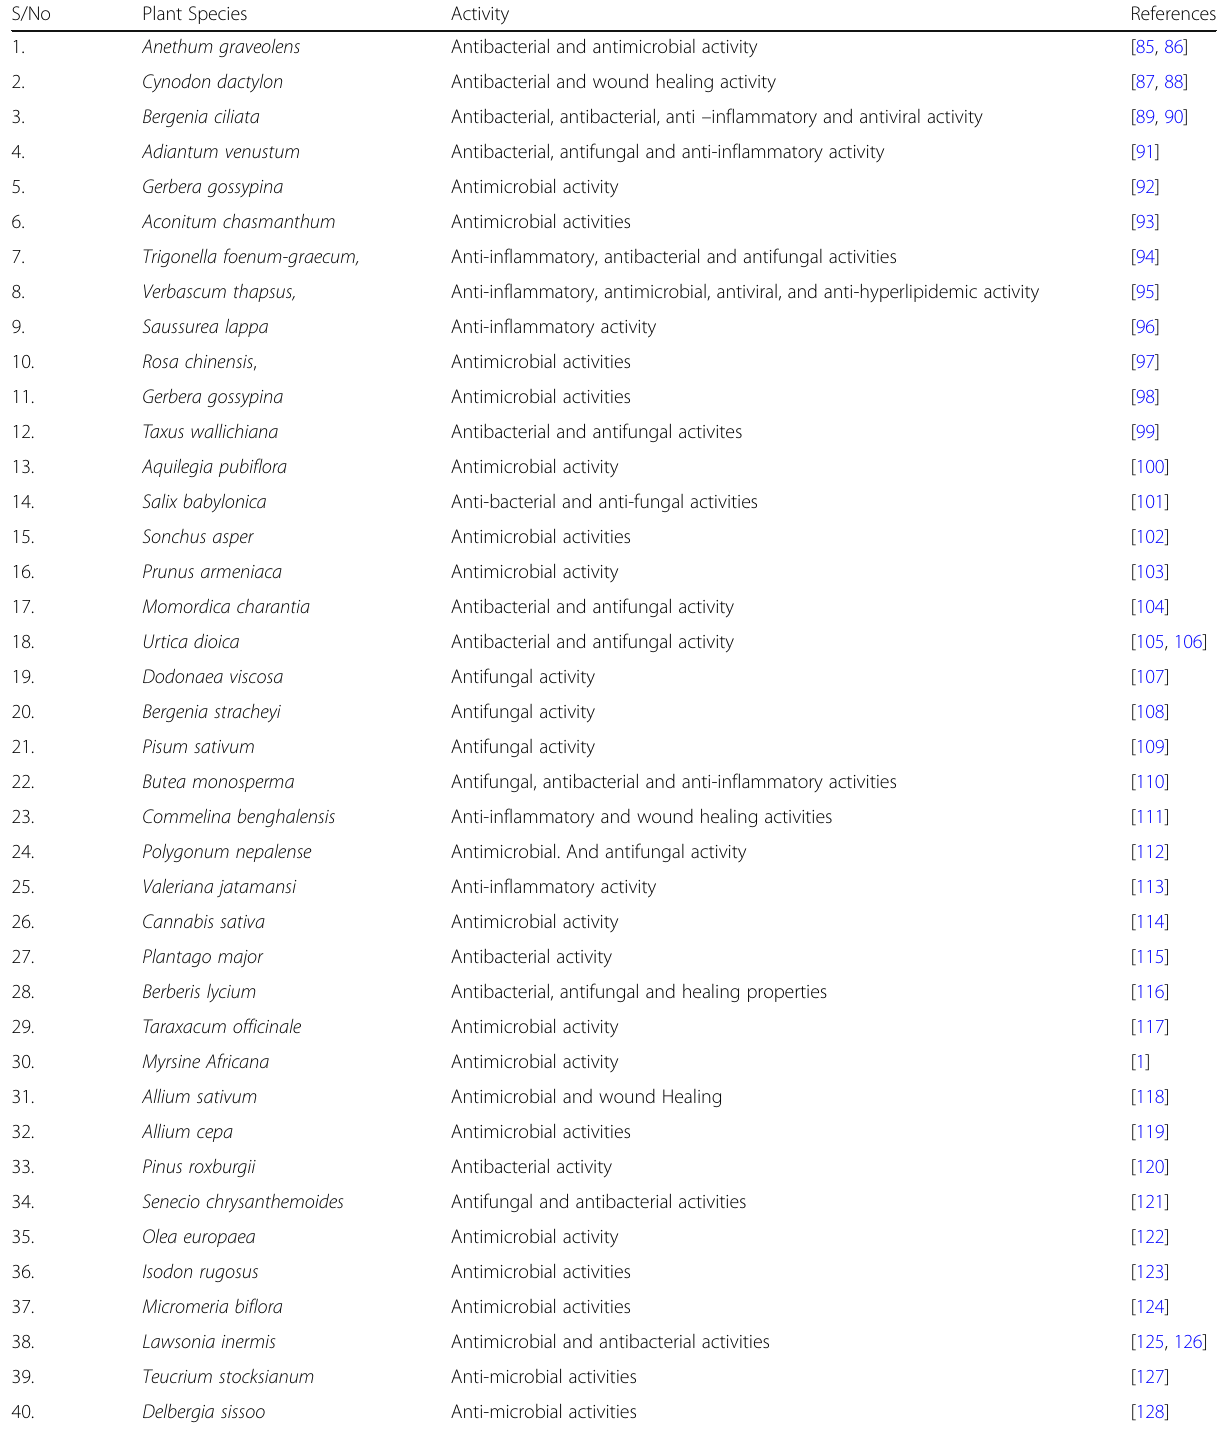
Table 4 Literature on preliminary in vitro screening of most cited plants S/No Plant